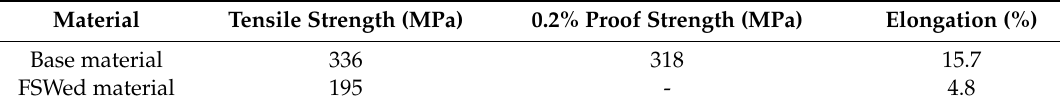
Table 3. The mechanical properties of the A6061-T6 BM and FSWed